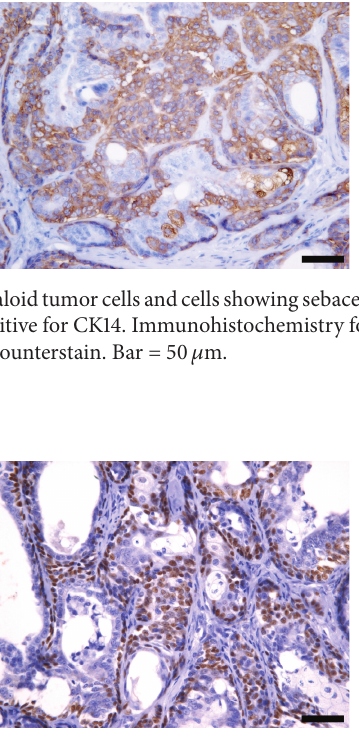
Figure 5: Basaloid tumor cells are positive for p63. Immunohisto- chemistry for p63 with hematoxylin counterstain. Bar = 50 𝜇 m.